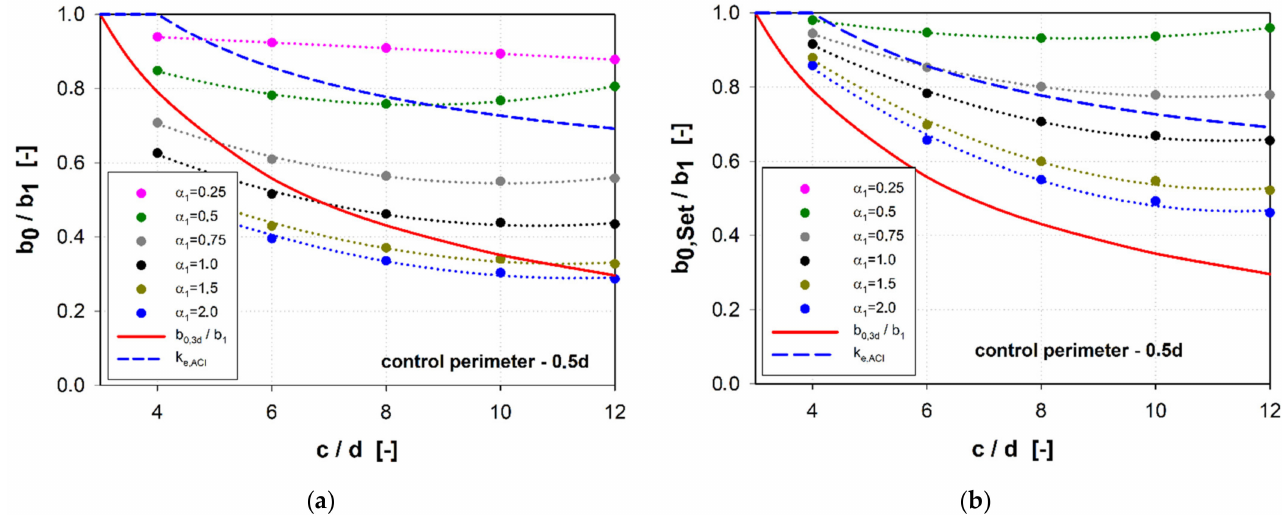
Figure 12. Comparison of methods for calculating the effective length of a control perimeter 0.5 d : ( a ) reduction of the control perimeter according to the general method of MC2010 ( b 0 / b 1 ); ( b ) reduction of the control perimeter according to [36] ( b 0, Set / b 1 ).